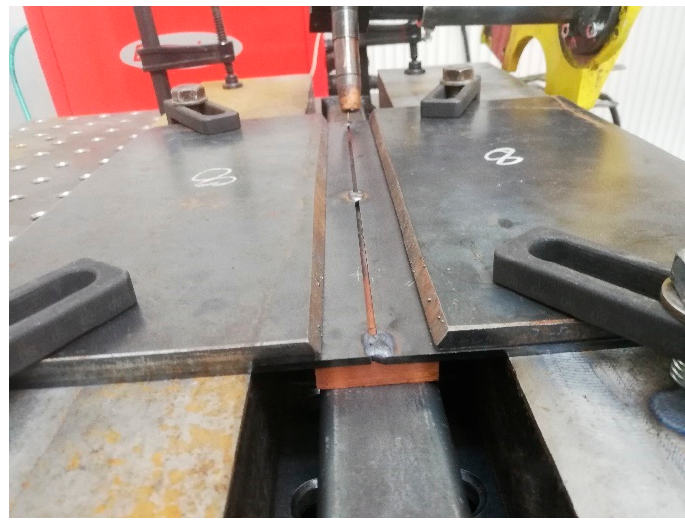
Figure 2. Welding with accelerated